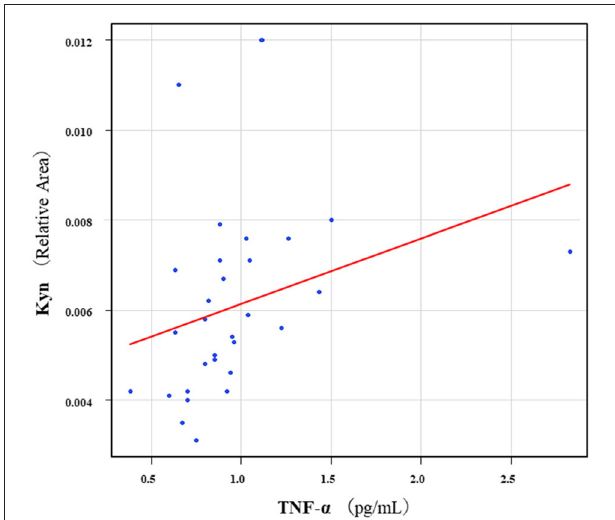
FIGURE 1 | Association between serum TNF- α levels and serum Kyn levels in the schizophrenia group. A significant positive correlation was found between the serum TNF- α levels and the serum Kyn levels ( r = 0.53, p = 0.0026). Relative Area: The peak areas of the metabolites were normalized against those of the internal standards, and the resultant relative areas were further normalized by the sample amount explained in the Measurement of